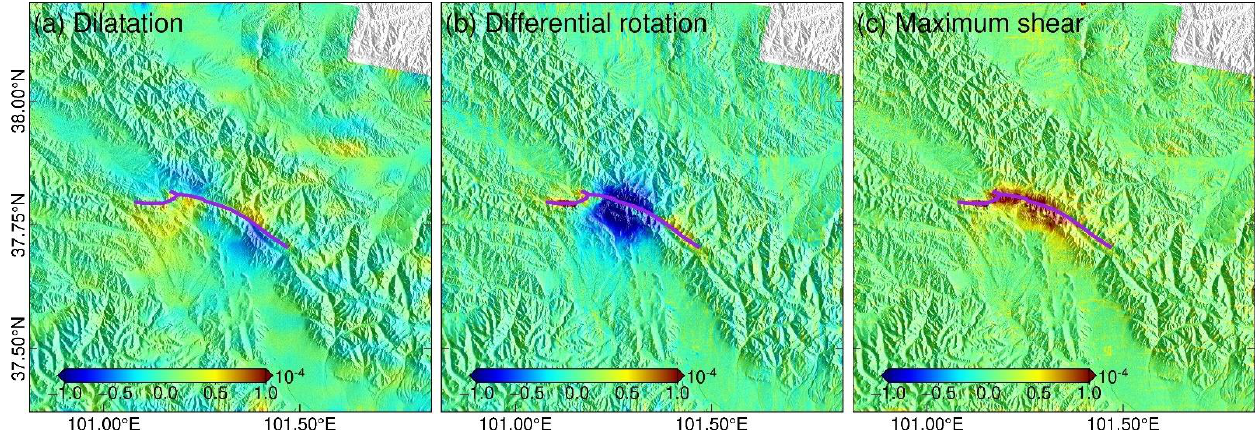
Figure 5. Three strain invariants for the 2022 Menyuan earthquake. Note that the strain invariants are dimensionless (i.e., no unit). ( a – c ) are dilatation, differential rotation, and maximum shear maps, respectively.